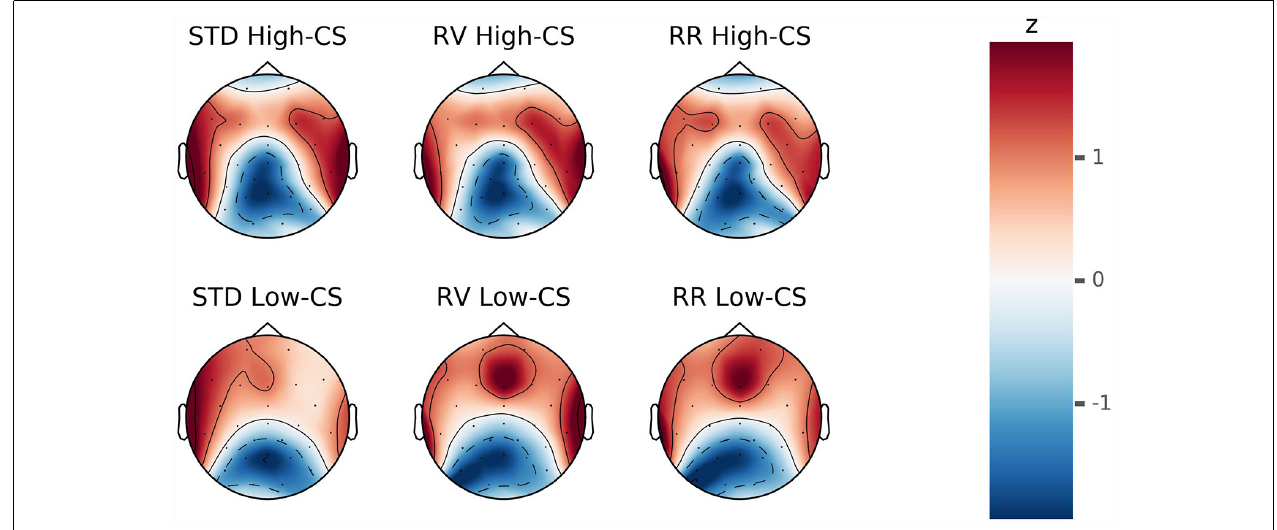
FIGURE 8 | Z-transformed voltage distributions during response-locked ERP after correct responses in a time window of 200–300 ms. The upper and lower heads show distributions of participants scoring high and low on conscientiousness (CS), respectively. The distributions of each group are displayed separately by column for the instruction conditions standard (STD), rule violation (RV) and rule reversal